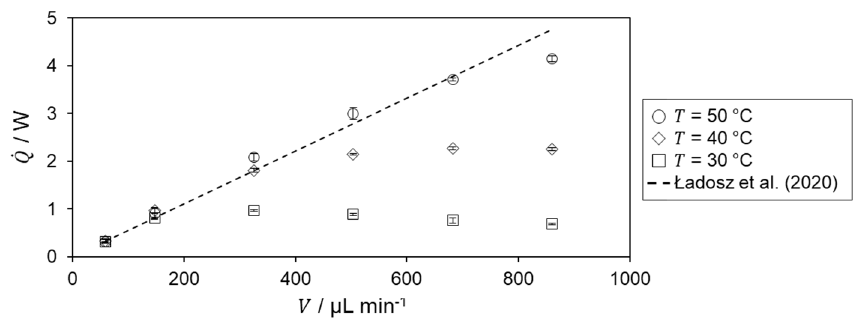
Figure 6. Heat of reaction of hydrolysis of acetic anhydride at different temperature and volumetric flow rate. Literature value by Ładosz et al. [17] is indicated by dashed black line.